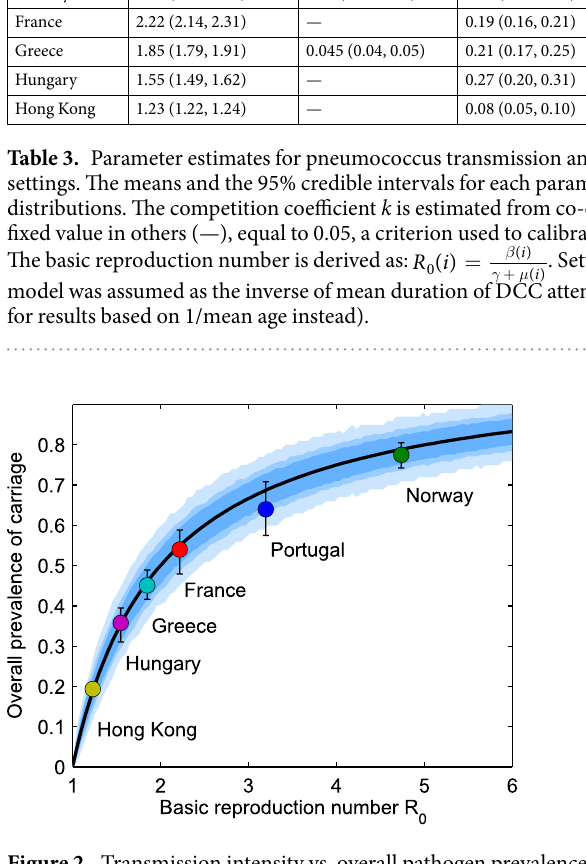
Figure 2. Transmission intensity vs. overall pathogen prevalence in a SIS framework. The mean R 0 ’s estimated from our datasets are matched with the expected overall prevalence of pneumococcal carriage in the pre- vaccine era. The bars reflect the 95% confidence interval for binomial proportions over 300 simulations with same R 0 , taking into account the mean sample size in each setting (Table 1). The line depicts the theoretical nonlinear relationship expected by the model (Eq. (1)). The shaded regions represent the 95% quantile of simulations under different sample sizes: n = 100 (light blue), n = 250 (darker blue) and n = 500 (darkest